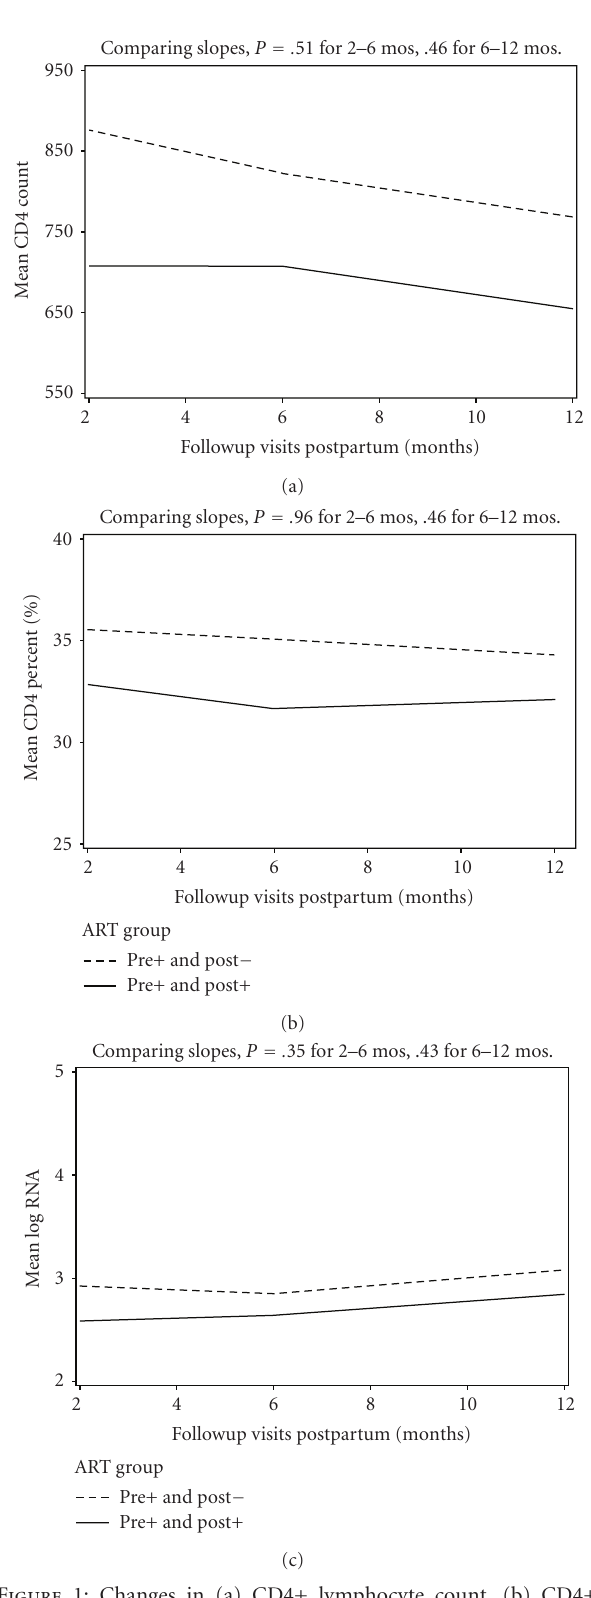
Figure 1: Changes in (a) CD4+ lymphocyte count, (b) CD4+ lymphocyte percentage, and (c) HIV RNA levels between two months and 12 months after delivery among all women (regardless of antiretroviral regimen) stopping (dashed line) or continuing (solid line) antiretroviral therapy after